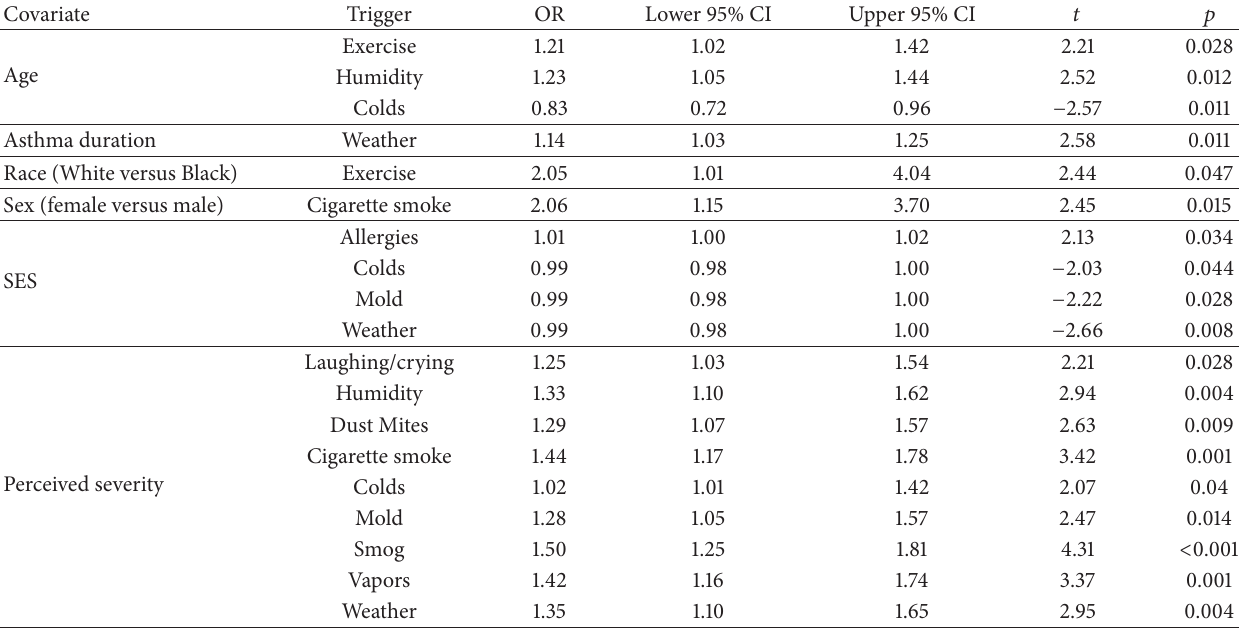
Table 1: Associations between covariates and individual